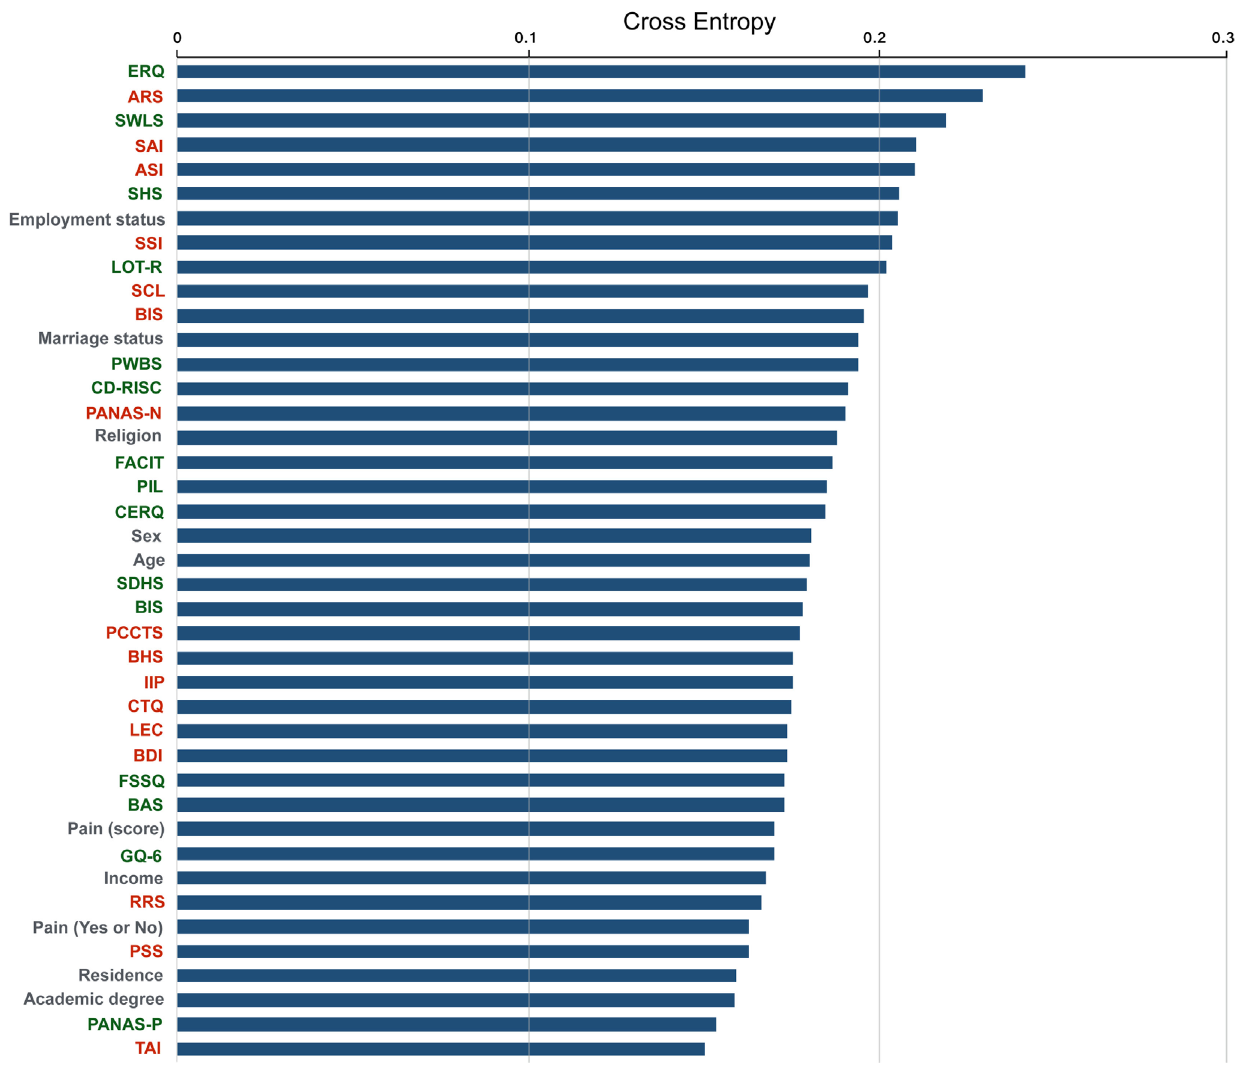
FigUre 2 | Contribution ranking for classifying suicide attempts with all predictors. The text colored in green represents scales that mainly measure positivity, whereas the text colored in red represent scales primarily measuring negativity. The gray text denotes the sociodemographic